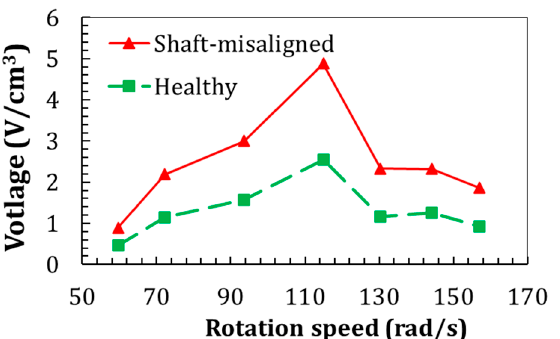
Figure 18. The comparison of voltage density from the DC motor at healthy and shaft-misaligned conditions.